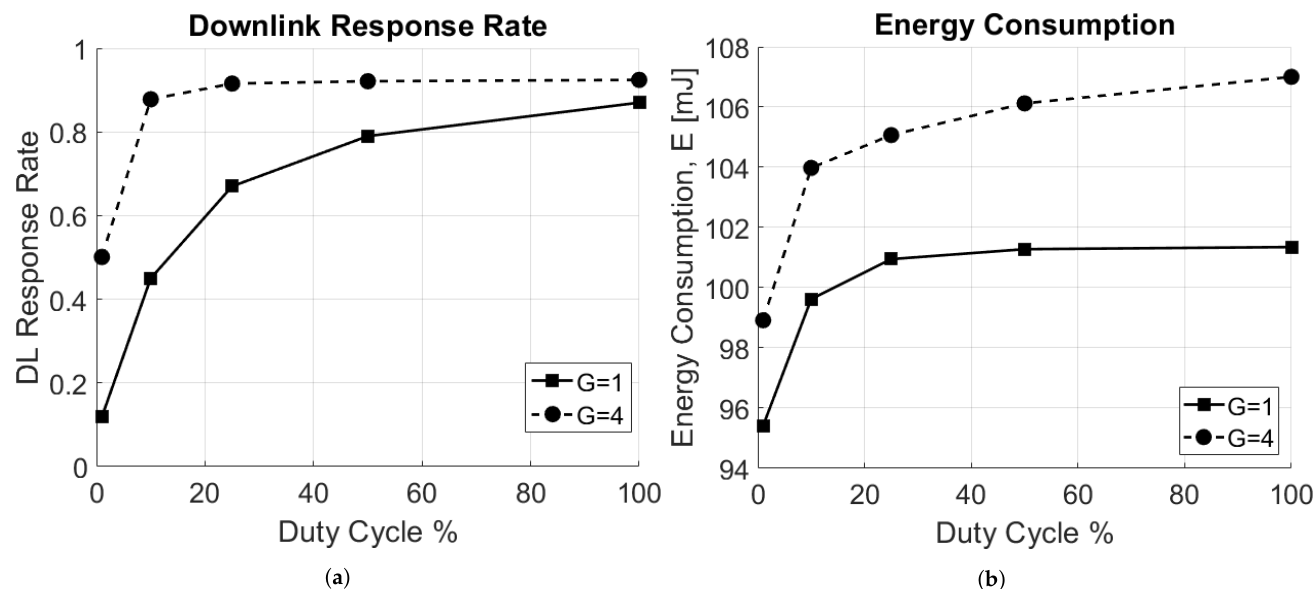
Figure 9. Impact of the duty cycle, DC. ( a ) Downlink response rate. ( b ) Energy